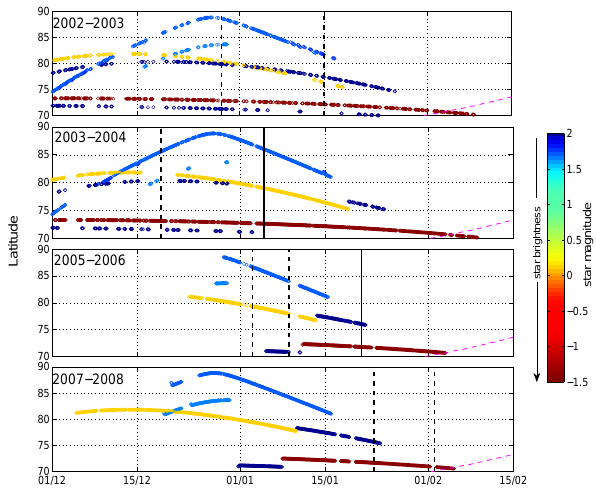
Figure 1 GOMOS data availability in the latitudinal band 70 ° -90 ° N in four winters. Colour indicates the visual magnitude of the occulted stars: the smaller the visual magnitude the brighter the star. Black dashed and solid lines indicate onsets of minor and major SSW, respectively. Pink dashed lines indicate the latitude of the polar night terminator.